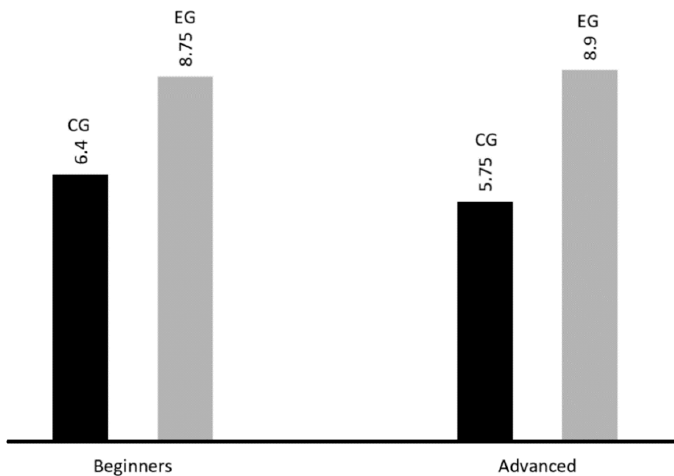
Figure 6. Average of the results of beginners and advanced groups.